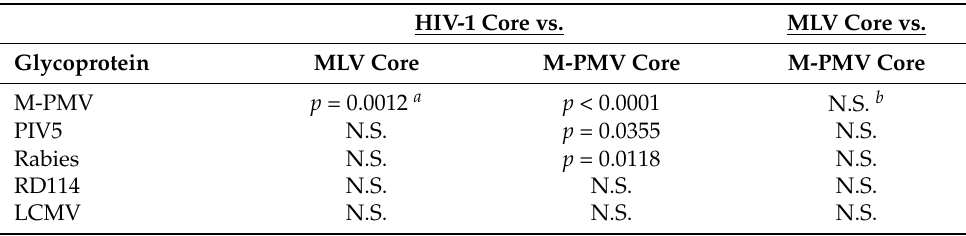
Table 2. Virion core dependency of SERINC5 antiviral activity.